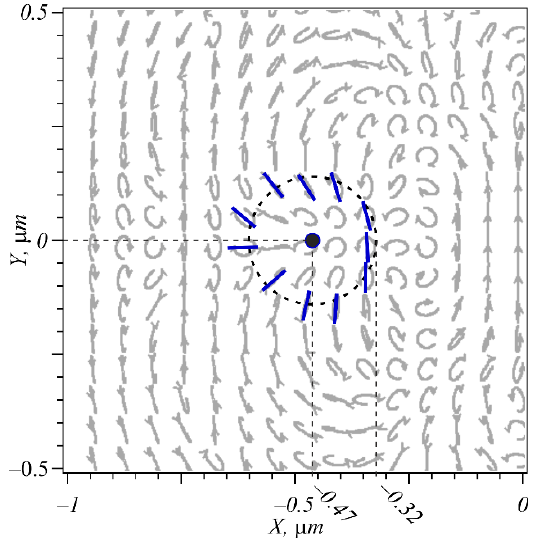
Figure 5. Polarization ellipses for a field fragment at the focus depicted in Figure 4e (limited by − 1 µm < x < 0; − 0.5 µm< y < 0.5 µm) and a C-point with Ic = 1/2 (found at − 0.47 µm; 0) marked with a black point around which the major axes of the polarization ellipses centered on a circle of radius 0.15 µm are depicted as blue lines.